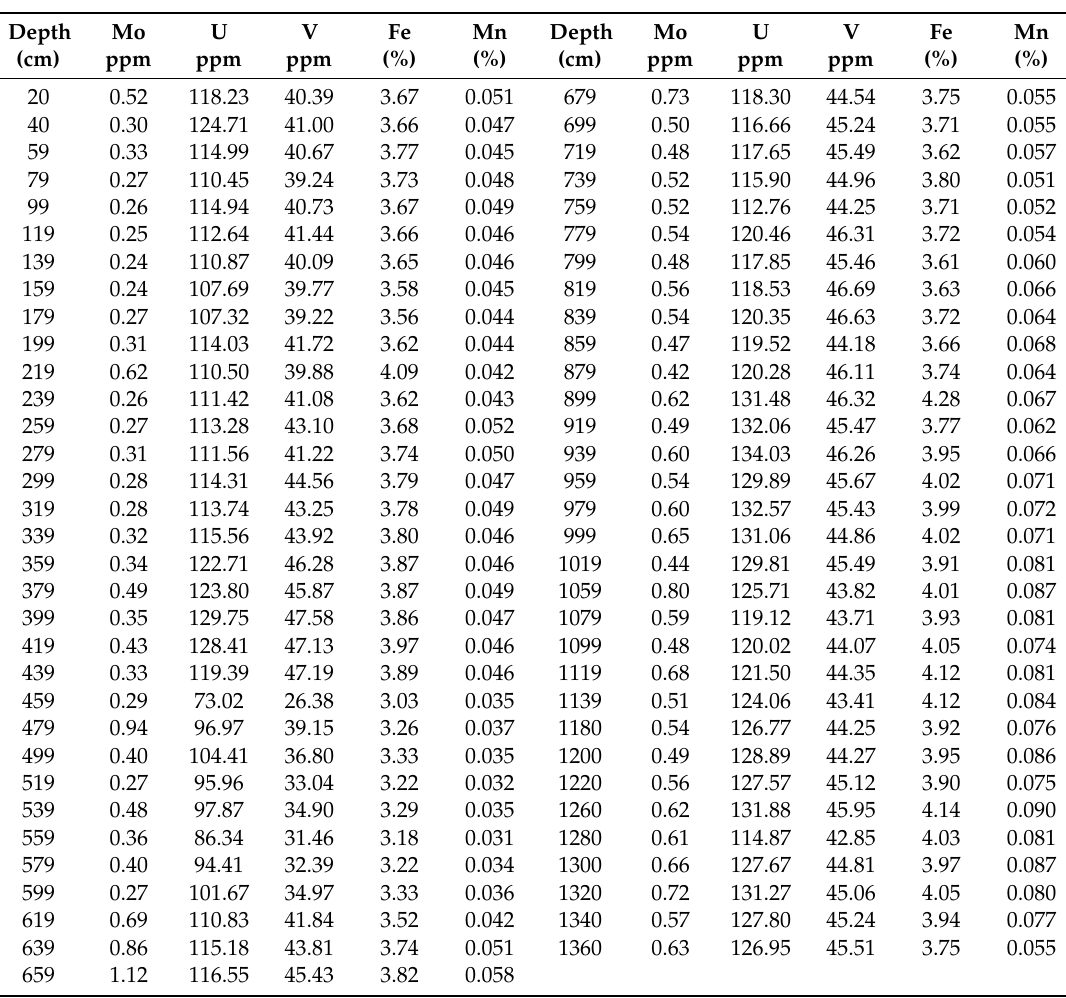
Table A2. Redox-sensitive element contents in the sediments of site